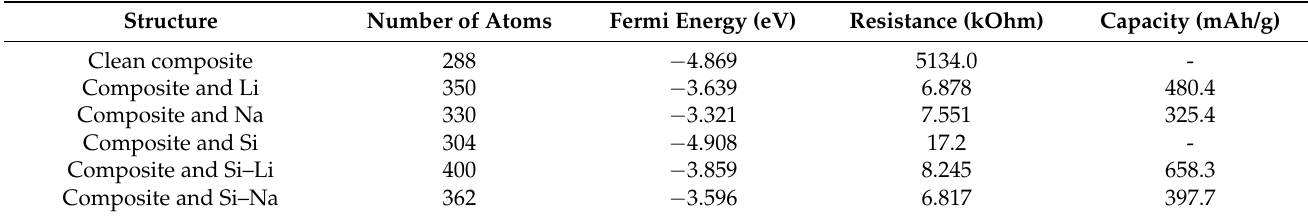
Table 1. Basic Table 1. Basic parameters.